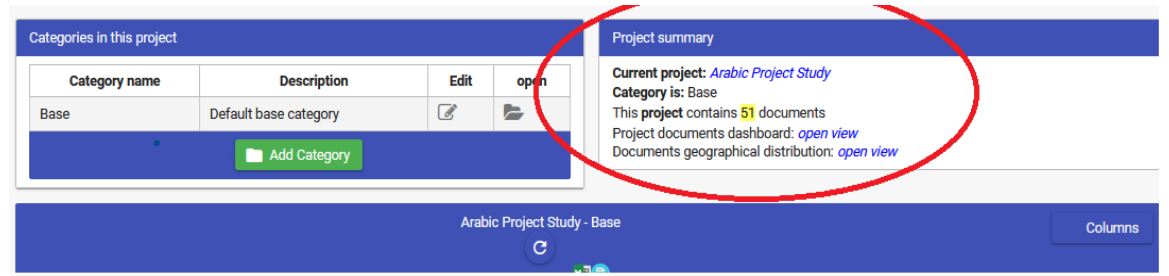
Figure 4. Project summary dashboard.